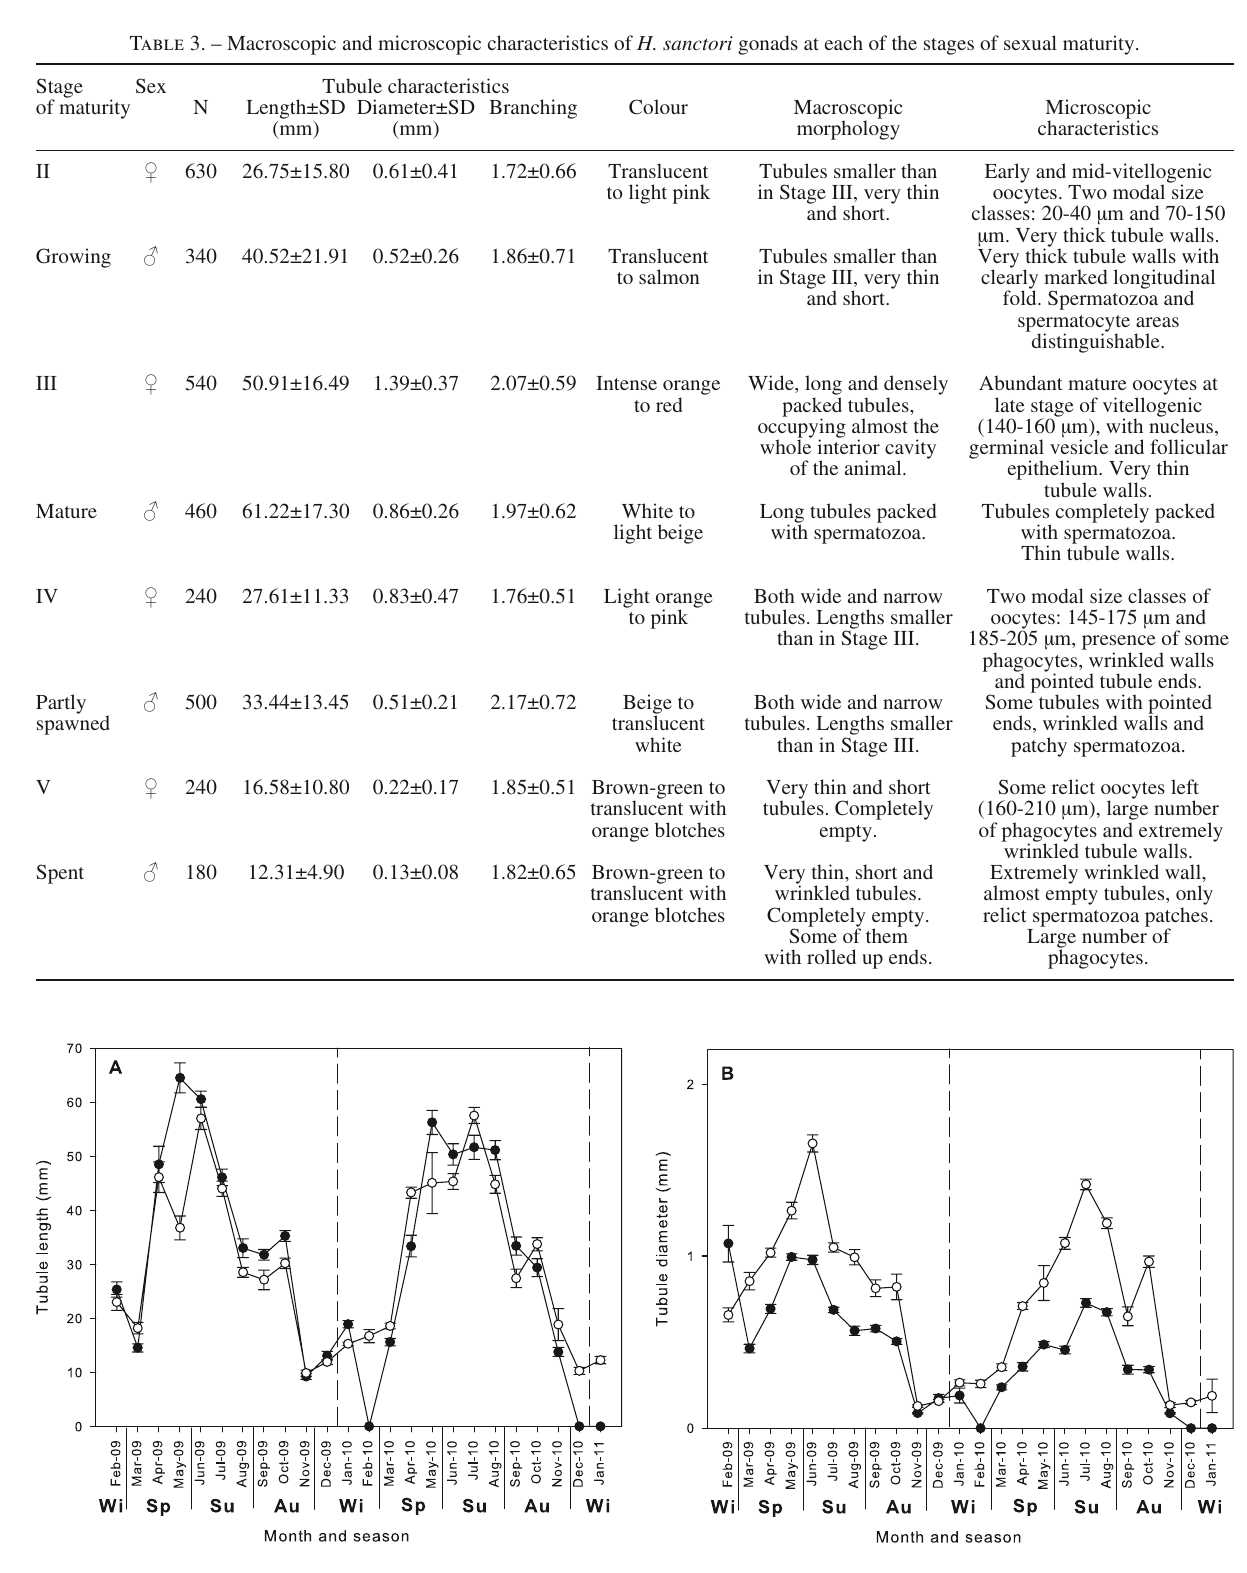
Fig . 6. – Monthly mean length (A) and diameter (B) of H. sanctori gonad tubules at Gran Canaria. The seasons are represented as: Wi, Winter; Sp, Spring; Su, Summer; and Au, Autumn. Males: full circles. Females: empty circles. The error bars are the standard error of means. Mean GI from Feb-2009 to Jan-2010 were pooled from three sites, while mean GI from Feb-2010 to Jan-2011 were pooled from two